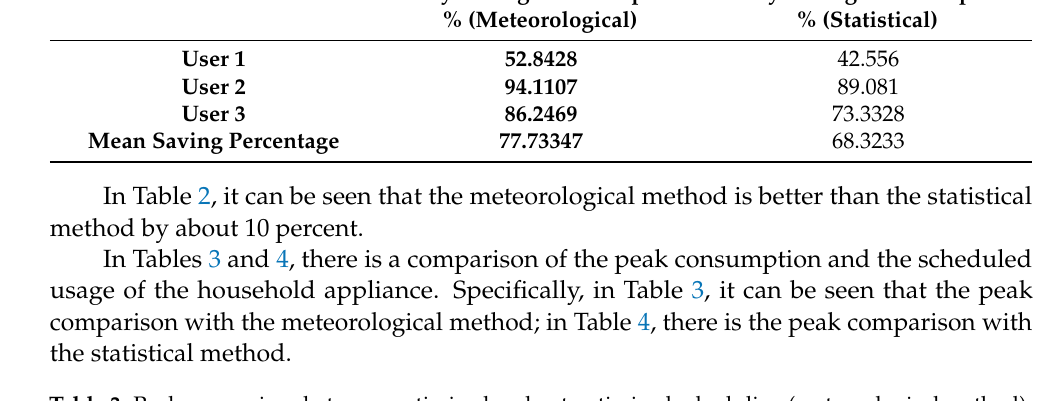
Table 3. Peak comparison between optimized and not optimized scheduling (meteorological